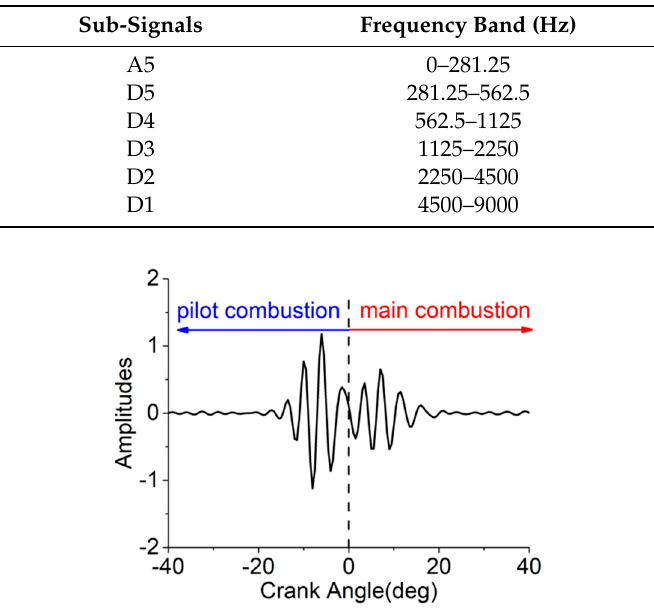
Figure 6. Pilot and main phases of an arbitrary sub-signal.